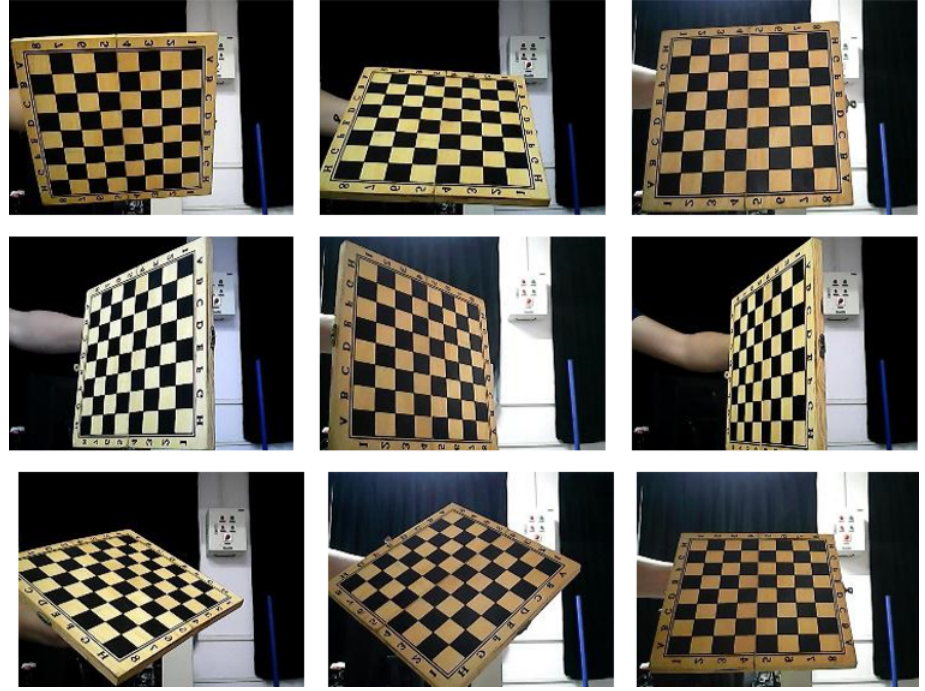
Figure 4. Camera capture chessboard